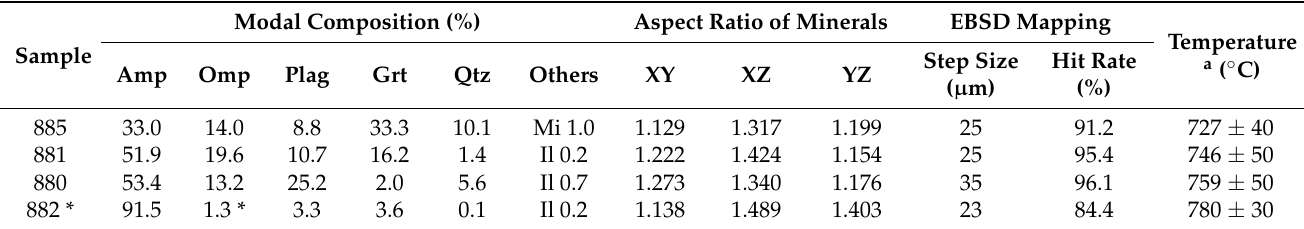
Table 1. Modal composition, aspect ratio, settings of electron back-scattered diffraction (EBSD) mapping, and estimated equilibrium temperature of